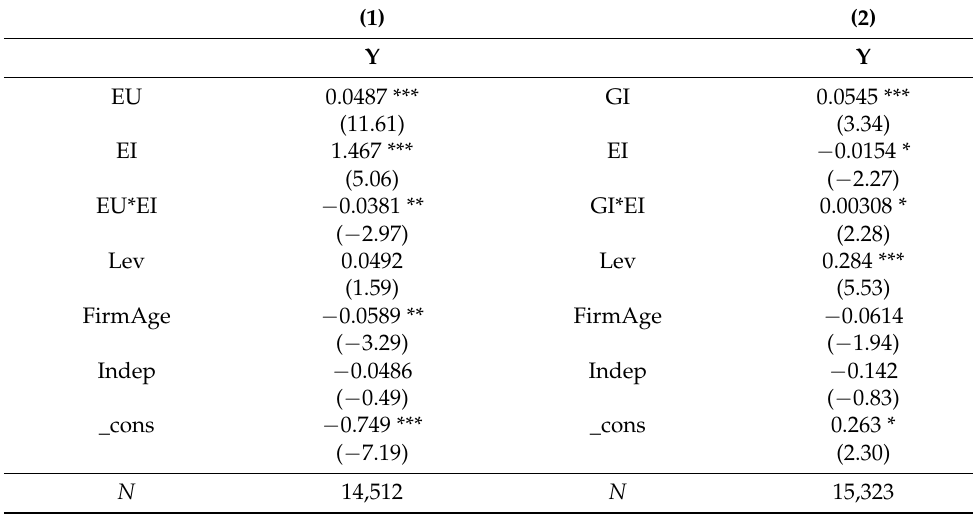
Table 5. Robustness results.